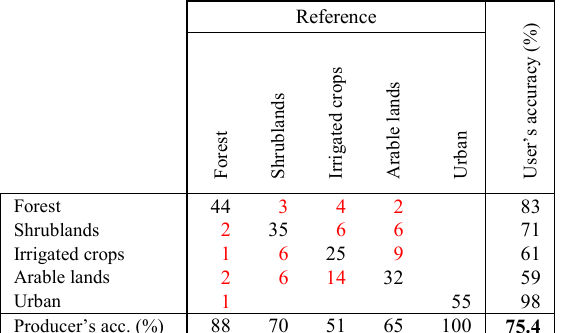
Table 2. Confusion matrix of the classification using texture features from TerraSAR-X data.